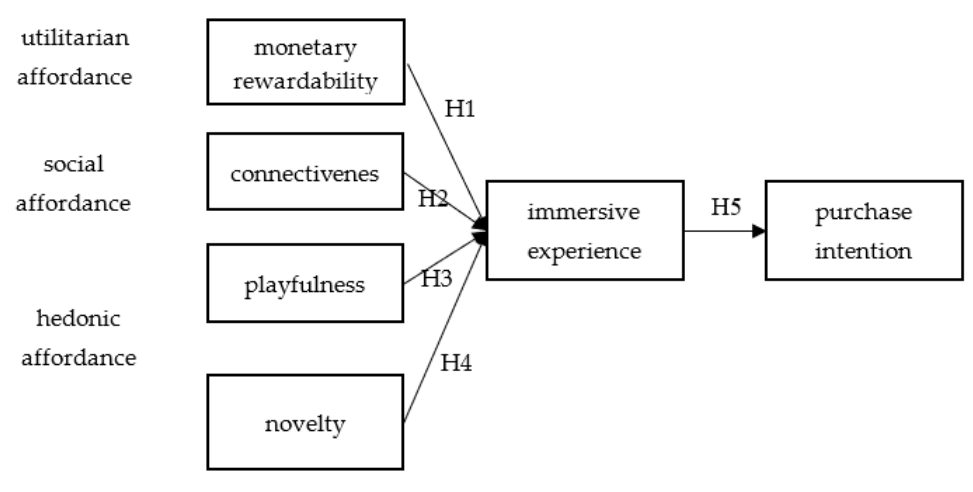
Figure 1. Research